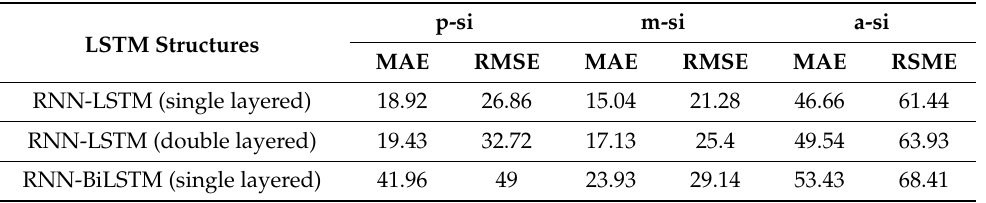
Table 2. Comparison of different LSTM structures with RNN for power output prediction for three different PV plants using 2019